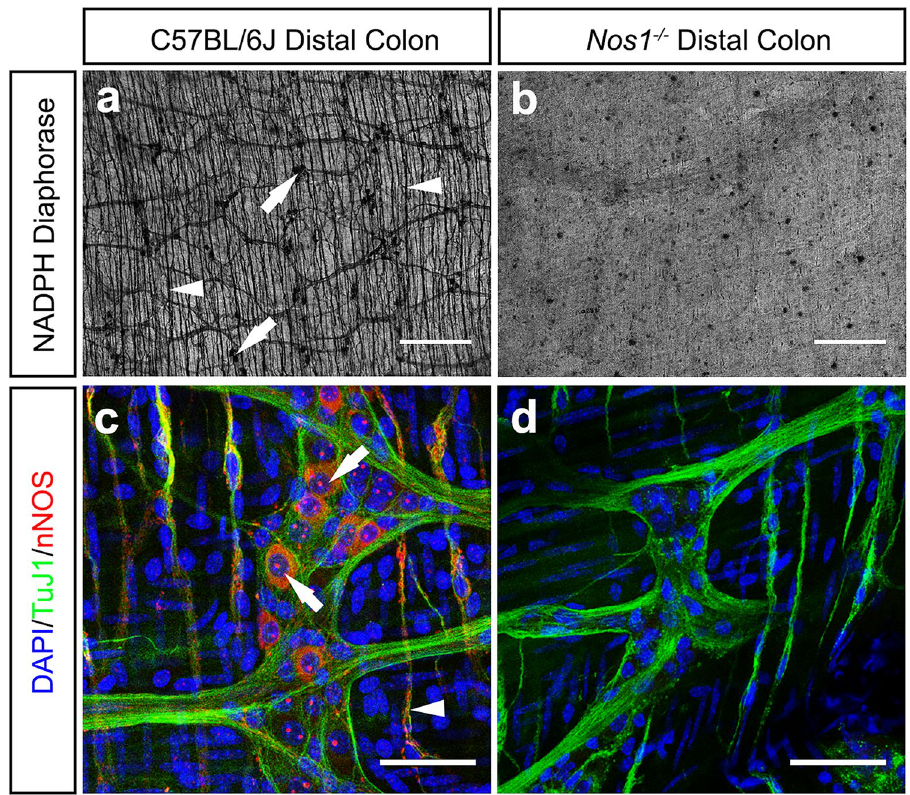
Figure 1. Nos1 −/− mice display complete loss of nNOS neurons in the distal colon. ( a ) Representative low- power image of NADPH diaphorase staining in wild-type C57BL/6J. nNOS + cell bodies (arrows), within enteric ganglia, and nNOS + fibres (arrowheads) are indicated. ( b ) Representative low-power image of Nos1 −/− distal colon demonstrating loss of nitrergic neurons as seen with the absence of NADPH diaphorase staining. ( c ) Representative high-power confocal z-stack image demonstrating the presence of nNOS + (red) neuronal cell bodies (arrows) within TuJ1 + (green) ganglia structures at the level of the myenteric plexus. nNOS + TuJ1 + intramuscular nerve fibres could also be observed in the C57BL/6J colon (arrowhead). ( d ) Representative high- power confocal z-stack image demonstrating the absence of nNOS + immunoreactivity within the Nos1 −/− colon. In the absence of nNOS + both TuJ1 + ganglia-like structures and intramuscular neurons can be observed in Nos1 −/− colonic tissue. Blue = DAPI. Scale bars, 500 μm ( a , b ) 50 μm ( c , d